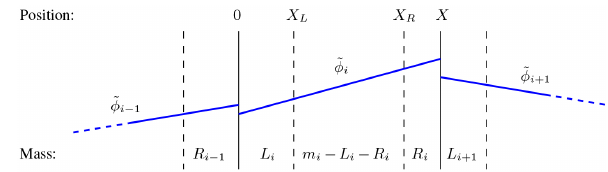
Figure 6. Schematic showing the incoming and outgoing mass fluxes for box i together with the proportions of the box that they